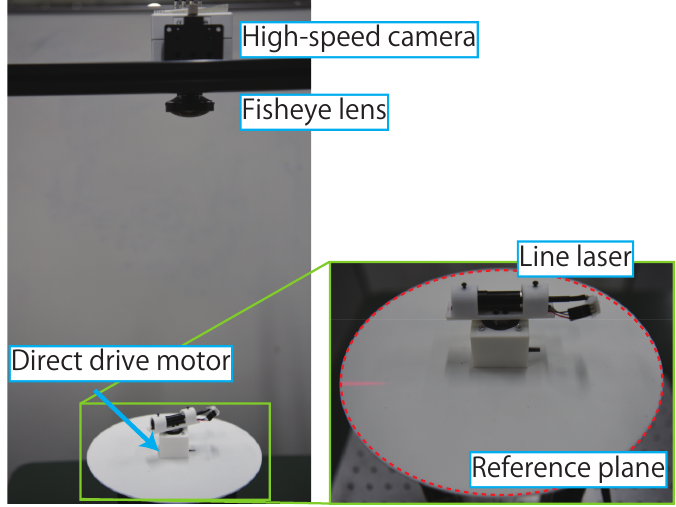
Figure 9. Experimental configuration of adaptive 3D sensing